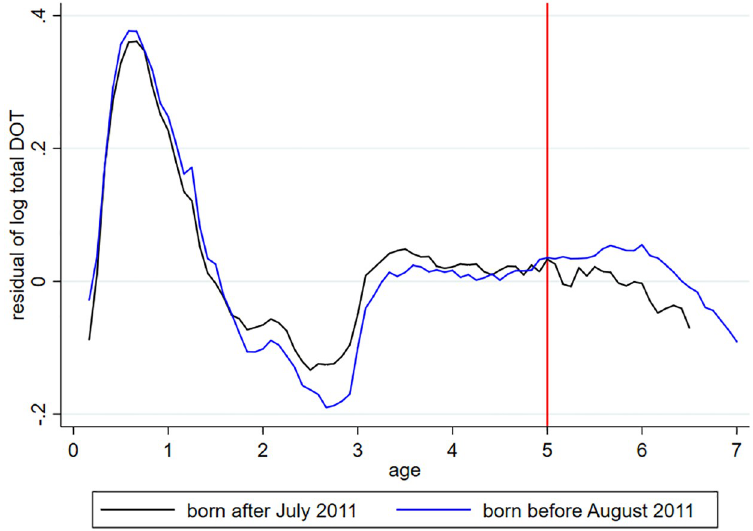
Fig 6. Residuals of the logarithm of antibiotic DOT as function of age, by cohort groups. The residuals are calculated from Eq (6).